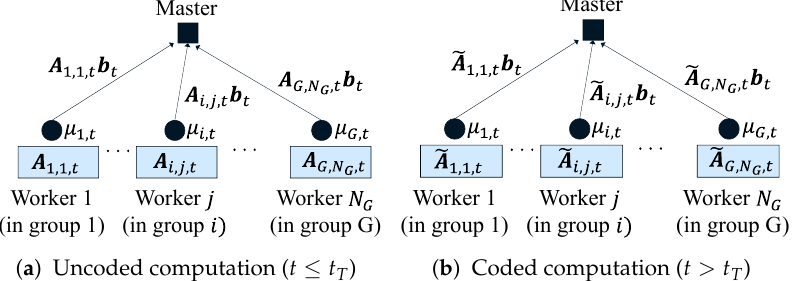
Figure 1. Illustration of the time-dependent heterogeneous cluster (task assigned at time t ). The master sends the input vector b t to the N workers, each of which stores A i , j , t and ˜ A i , j , t in uncoded and coded computations, respectively, for i ∈ [ G ] and j ∈ [ N i ] ; ( a ) worker j in group i computes the multiplication of A i , j , t and b t with the working rate µ i , t , and sends back the computation results to the master; ( b ) worker j in group i computes the multiplication of ˜ A i , j , t and b t with the working rate µ i , t , and sends back the results to the